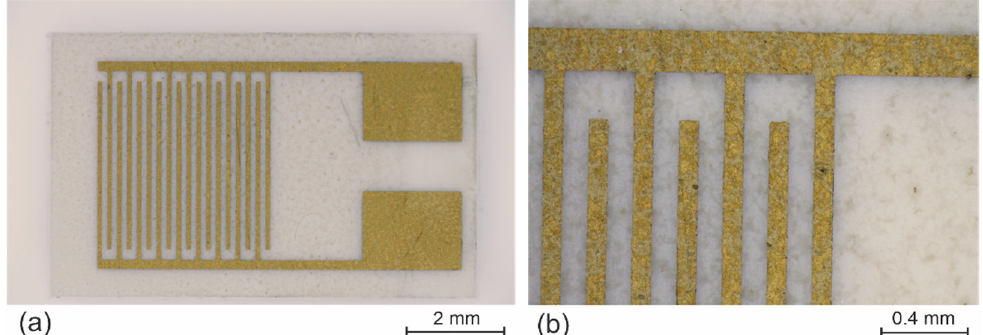
Figure 1. Images of alumina substrate with interdigital electrodes: ( a ) whole substrate; ( b ) detail of the interdigital electrodes.